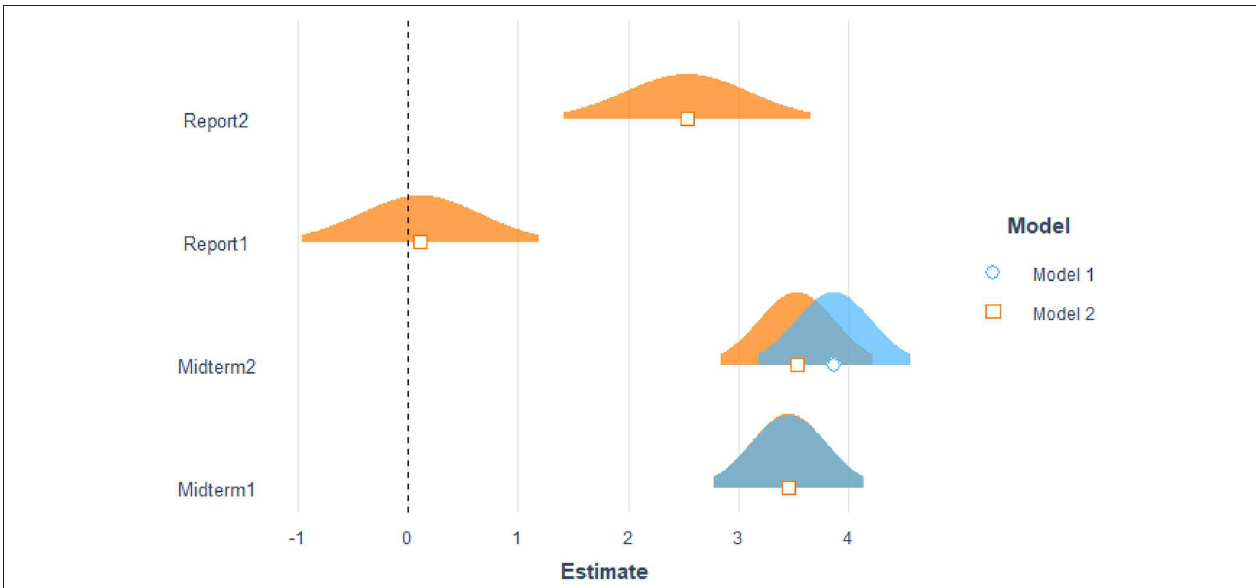
FIGURE 5 | Standardized regression coefficients and their distributions for the four predictors across the two regression